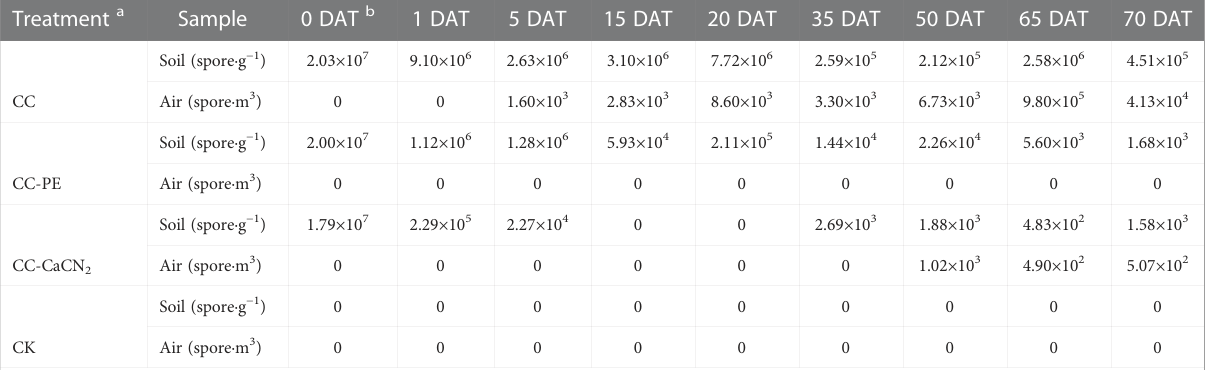
TABLE 4 The C. cassiicola content of soil and air was detected in different treatments. Treatment